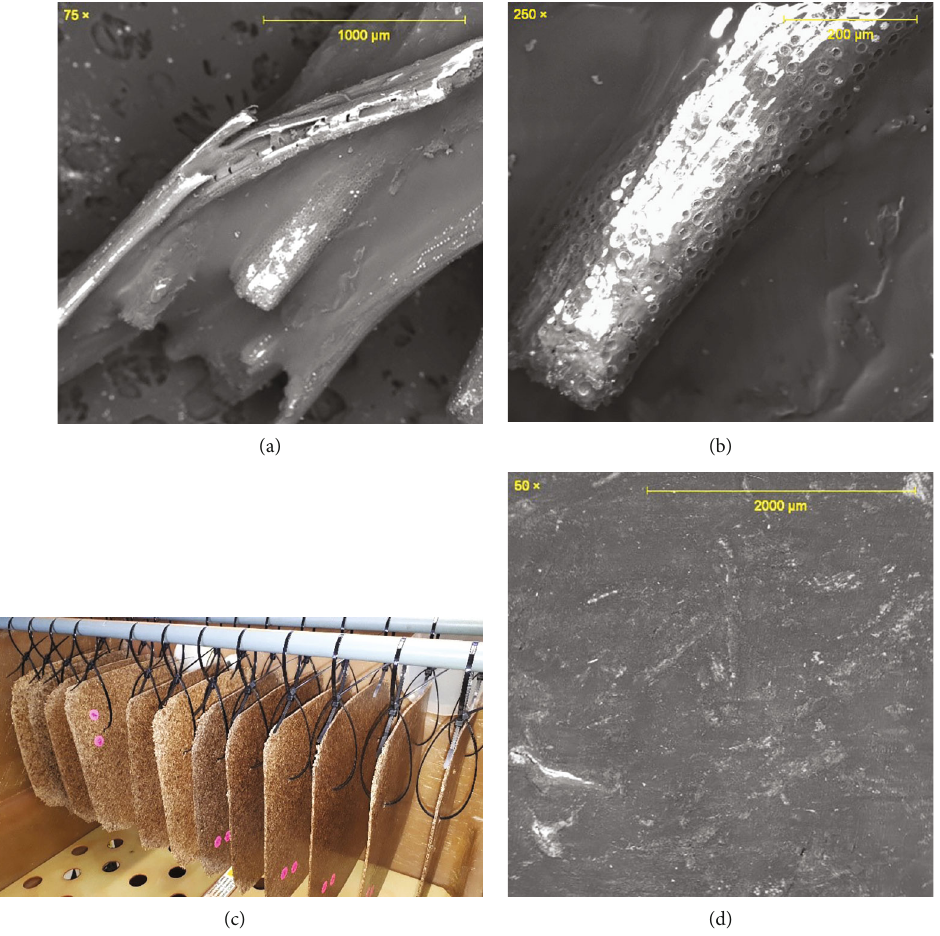
Figure 2: (a, b) SEM images of imbibed fi ber granule, (c) OPEFB/acrylic thermoplastic composites before salt spray testing, and (d) SEM image of composite before salt spray